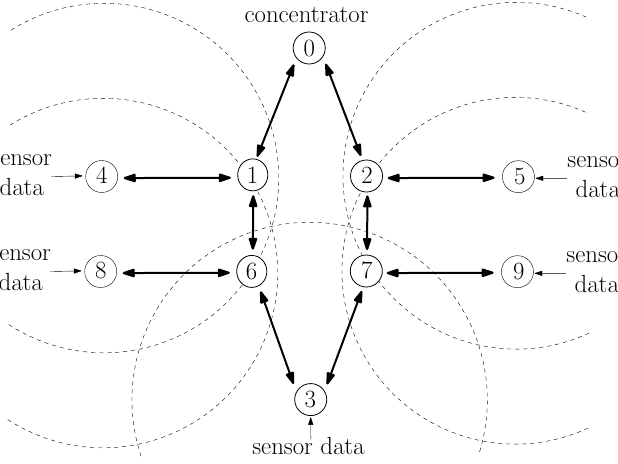
Figure 7. Topology with one-hop and two-hop